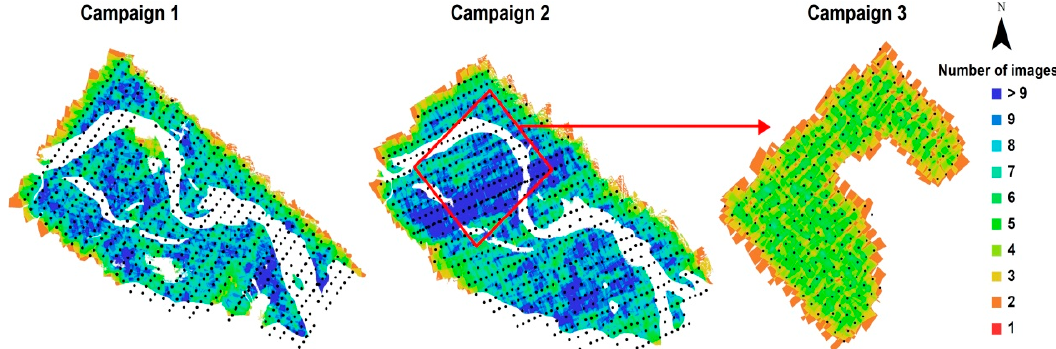
Figure 7. Image recovery maps for the three campaigns. Black points correspond to nadir images.